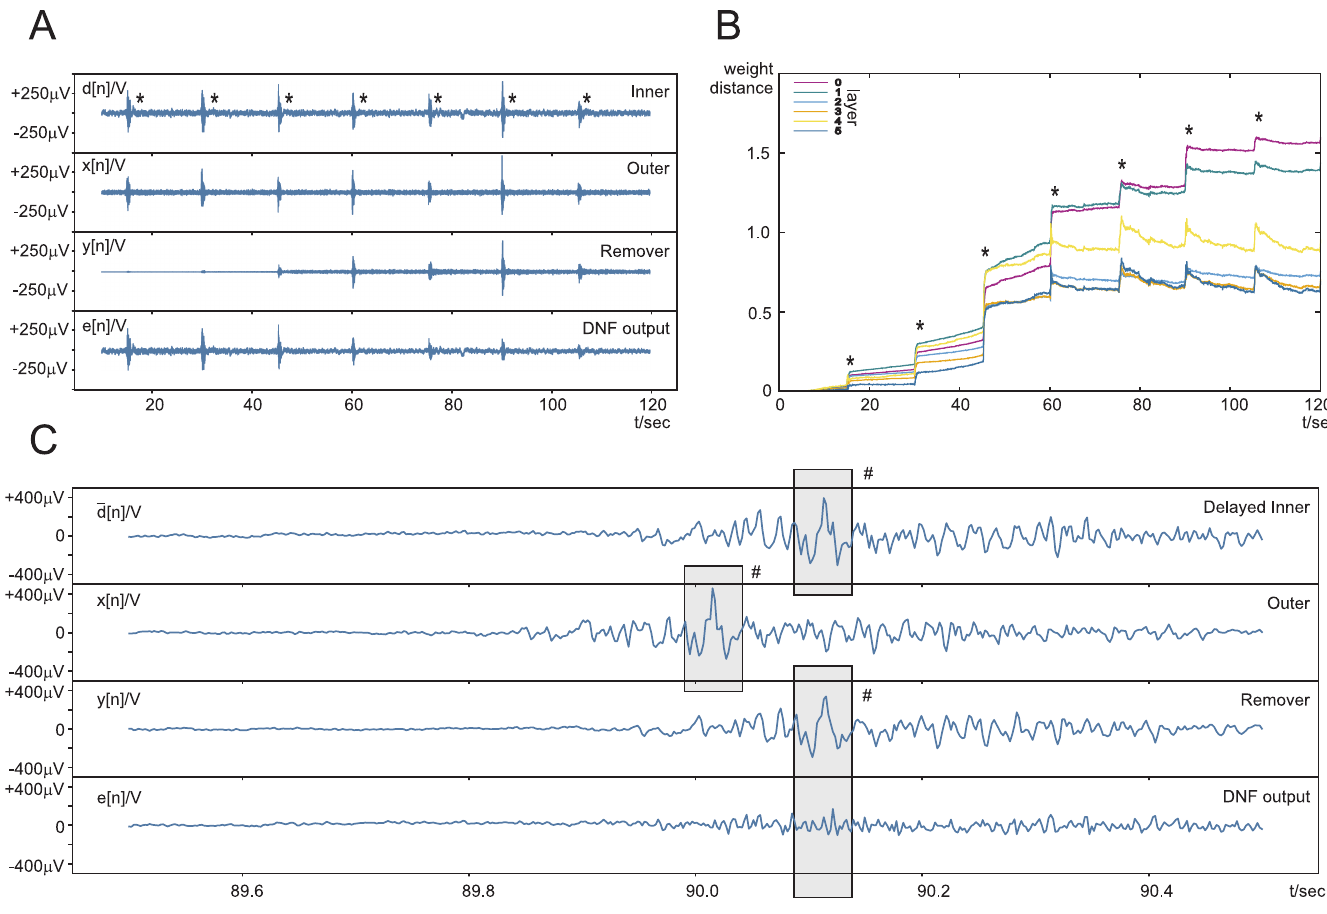
Fig 2. Signals and weight development from subject 10. The subject was asked to contract their jaw muscles every 15 seconds. The jaw contractions are indicated with a “ � ”. A: Four signal traces, namely: the inner electrode signal d [ n ] which carries a mix of EEG and EMG, the outer electrode signal x [ n ] which is the noise reference, the output of the DNN or the “remover” y [ n ], and the output of the DNF e [ n ] which is both the output and the error signal. B: Weight development: shows the Euclidean weight distance from the initial weights of the 6 different layers over time. C: Detailed plot of the same signals as panel A between 89.5 s and 90.5 s. The jaw clench starts at about 89.8